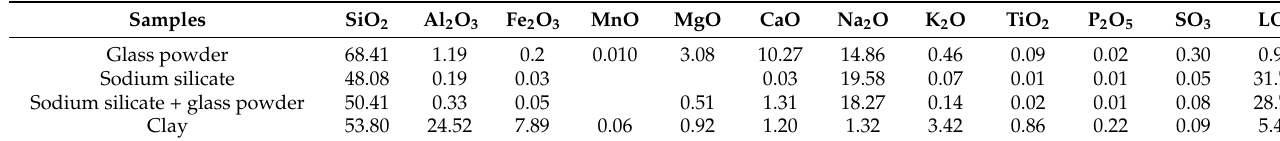
Table 2. XRF analysis of raw materials (wt %). Data normalized to 100% (LOI-free).